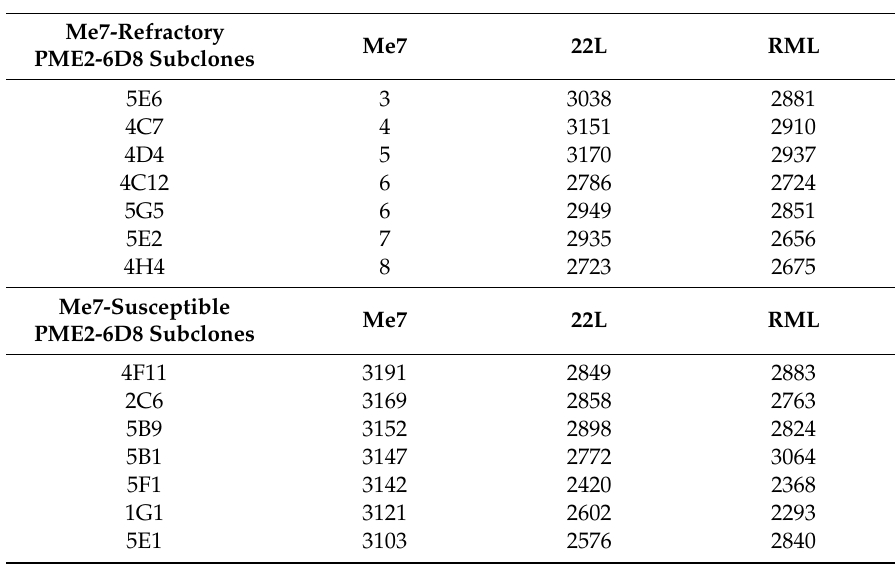
Table 3. Di ff erential susceptibilities of Me7-refractory and Me7-susceptible PME2-6D8 cell clones to three mouse-adapted brain